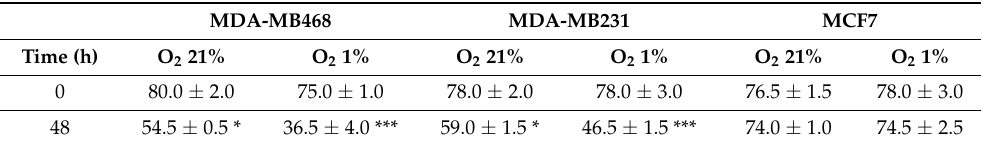
Table 1. Percentage of open scratch wound in MDA-MB468, MDA-MB231 and MCF7 cells following 48 h incubation under normoxic (O 2 21%) and hypoxic conditions (O 2 1%) (mean S.E. of 3